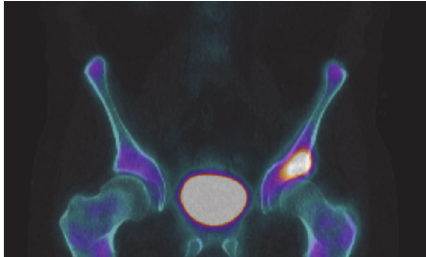
Figure 1: Delayed-phase SPECT/CT displaying increased activity in the left AIIS extending to the superior acetabular rim.